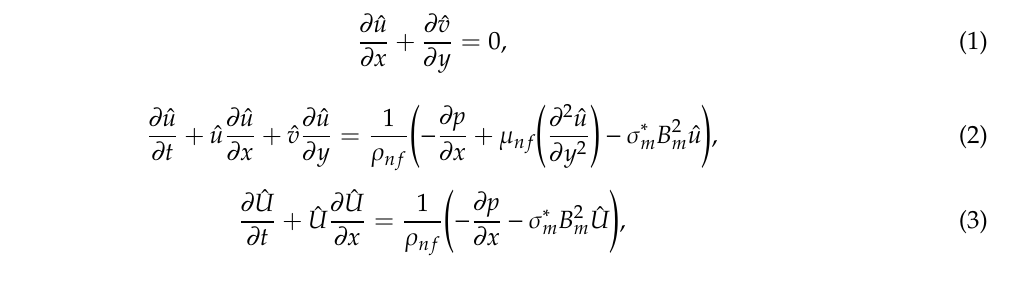
Figure 1. Flow of water and ethylene glycol (EG) suspended by γAl (cid:2870) O (cid:2871) nanoparticles.